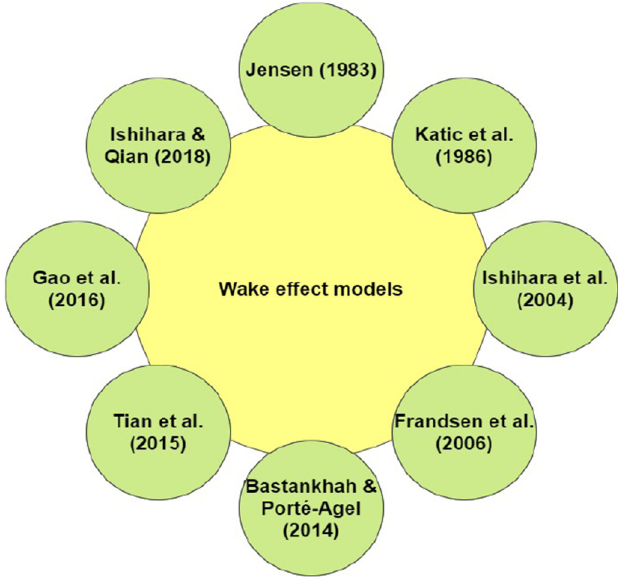
Fig. 3. Schematic representation of the wake models